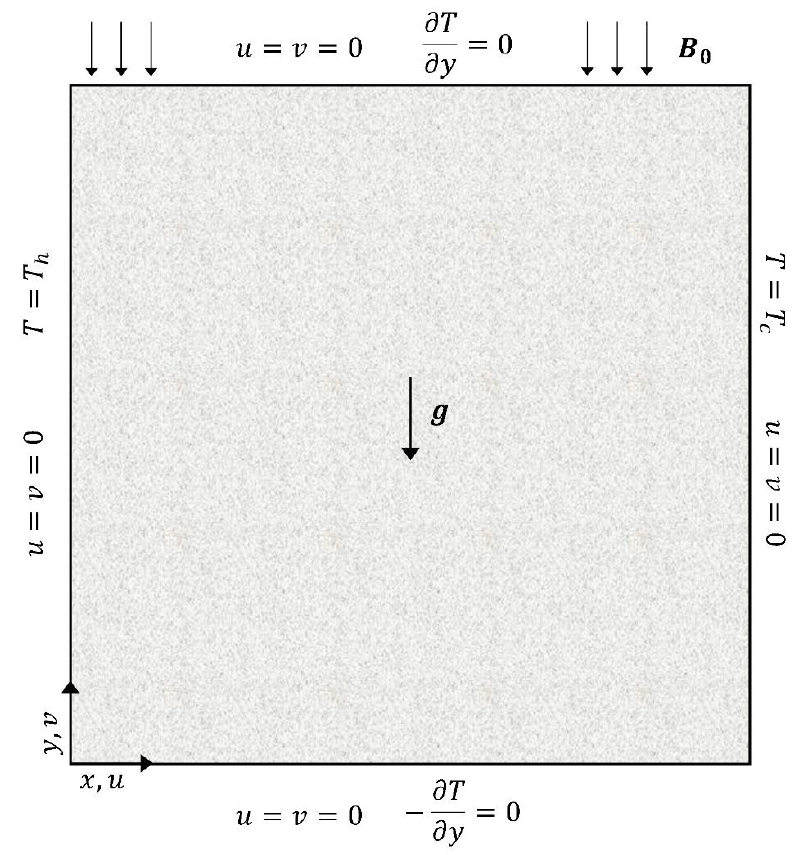
Figure 1. Geometry and boundary conditions of the problem.